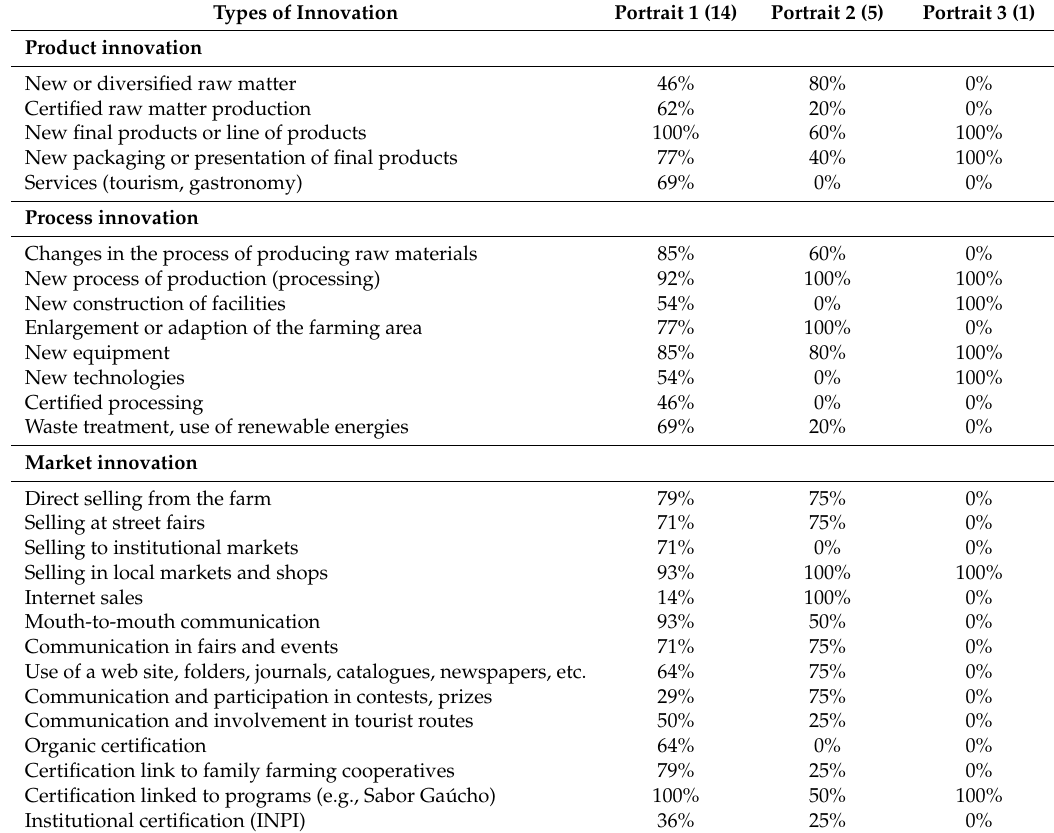
Table 2. Portraits of family agribusinesses based on different types of innovation. Frequencies (%) of presence (Sample 19 Brazilian farms, 27 variables of innovation).